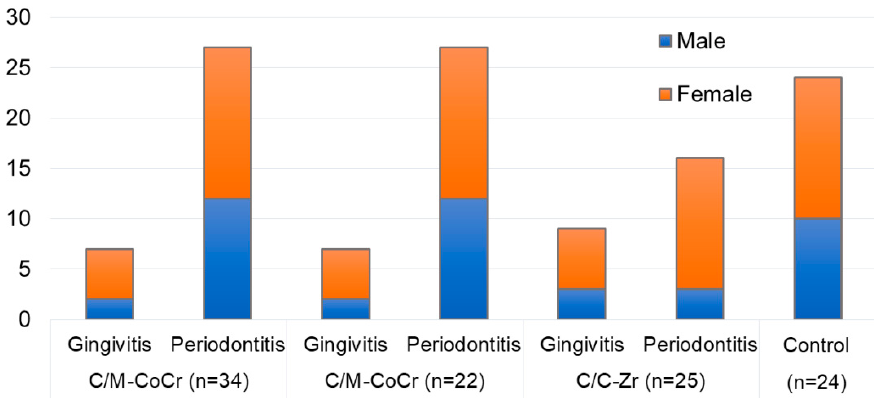
Figure 1. Distribution of patients in the three groups with fixed prostheses in gingivitis and periodontitis, and the healthy (control) group. The study included C/M-CoCr = Cobalt-chrome metal- ceramic prostheses by the conventional method; C/C-CoCr = Cobalt-chrome metal-ceramic prostheses prostheses by the conventional method; C / C-CoCr = Cobalt-chrome metal-ceramic prostheses by by CAD/CAM technique; C/C-Zr = zirconia-based ceramic prostheses by the computer-aided design CAD / CAM technique; C / C-Zr = zirconia-based ceramic prostheses by the computer-aided design and computer-aided manufacturing (CAD / CAM) and computer-aided manufacturing (CAD/CAM) technique.